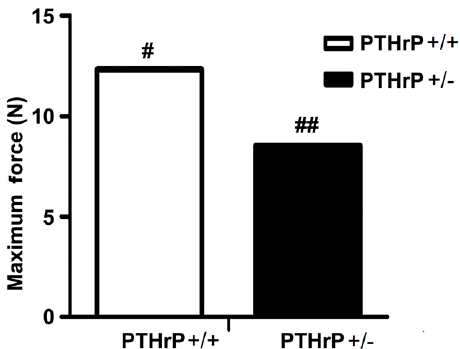
Figure 6. Effects of endogenous PTHrP deficiency on mechanical properties of fractured femurs at four weeks PF. Results revealed that maximum force at failure was less in PTHrP+/ − mice compared with WT mice ( n = 6). # p < 0.05 and ## p < 0.01, WT mice compared with PTHrP+/ − mice at the same group. PTHrP: Parathyroid hormone-related protein; WT: wild type.